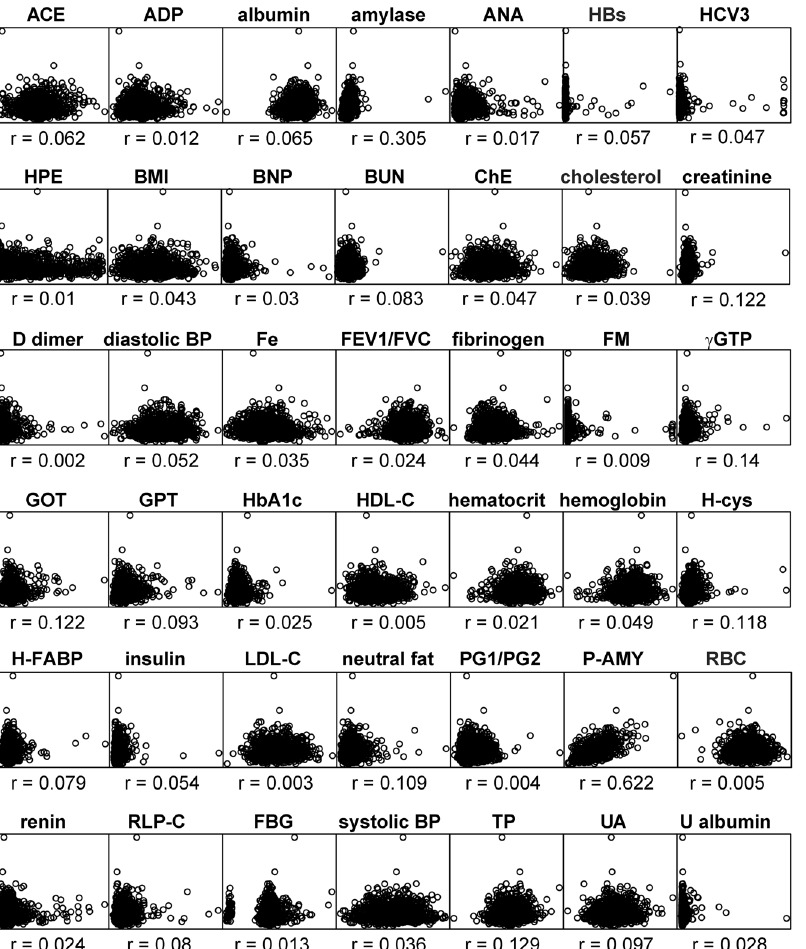
Figure 5. Scatter plots of the P-LIP levels with each of the other clinical test values in the Takahata population, where the plotted values are residuals from linear regression of each test value on age and gender. These plots show no strong correlation of each of other phenotypes to P-LIP. Each r denotes Pearson’s (product-moment) correlation coefficient. The names and abbreviations of the total of 43 quantitative values are listed below (asterisks denote that it is plasma level); ACE (angiotensin converting enzyme*), ADP (adiponectin*), albumin*, amylase*, ANA (antinuclear antibody*), HBs (hepatitis Bs antigen*), HCV3 (hepatitis C virus 3 antibody, index*), HPE (Helicobacter pylori antibody E*), BMI (body mass index), BNP (B-type natriuretic peptide*), BUN (blood urea nitrogen*), ChE (cholinesterase*), cholesterol (total cholesterol*), creatinine*, D dimer*, diastolic BP (diastolic blood pressure), Fe (iron*), FEV1/FVC (forced expiratory volume in 1s/forced vital capacity), fibrinogen*, FM (fibrin monomer complex*), gGTP (gamma glutamyl transpeptidase*), GOT (asparate aminotransferase*), GPT (alanine aminotransferase*), HbA1c (hemoglobin A1c*), HDL-C (high density lipoprotein cholesterol*), hematocrit, hemoglobin, H-cys (homocysteine*), H-FABP (Heart type fatty acid-binding protein*), insulin (before a meal*), LDL-C (low density lipoprotein cholesterol*), P-LIP (pancreatic lipase*), neutral fat*, PG1/PG2 (pepsinogen 1/2 ratio), P-AMY (pancreatic amylase*), RBC (red blood cell counts), renin*, RLP-C (remnant-like particle cholesterol*), FBG (fasting blood glucose*), systolic BP (systolic blood pressure), TP (total protein*), UA (uric acid*), and U albumin (urinary albumin).